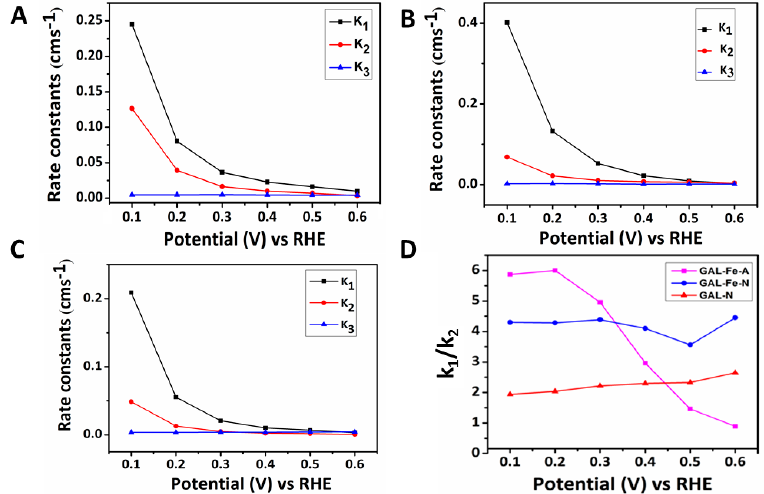
Figure 5. The rate constants for ( A ) GAL-N; ( B ) GAL-Fe-A; ( C ) GAL-Fe-Nis in the potential range of 0.1 V to 0.6 V; and ( D ) Comparison of k 1 /k 2 ratio for GAL-N, GAL-Fe-A and GAL-Fe-N.